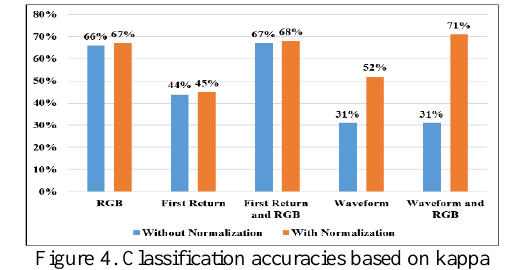
Figure 4. Classification accuracies based on kappa coefficient for each strategy.